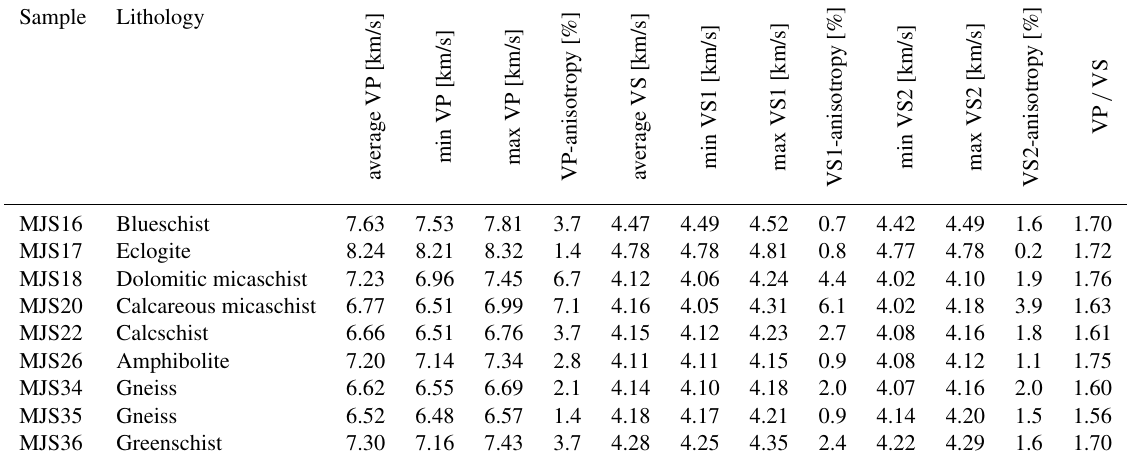
Table 2. P-wave (VP) and S-wave (VS) velocities, seismic anisotropies (VP-, VS1- and VS2-anisotropies %), and VP / VS ratios of all samples, modeled from